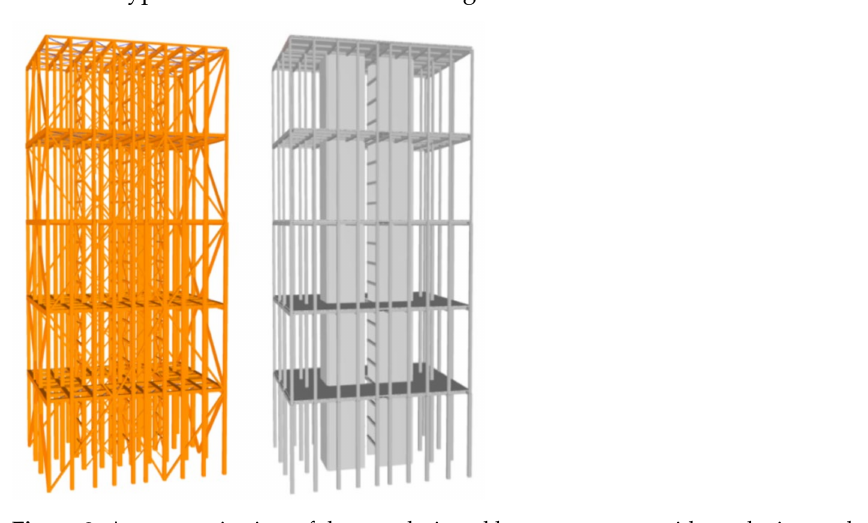
Figure 2. Axonometric view of the two designed hyperstructures without the internal substructures: glulam concept ( left ) and concrete concept ( right